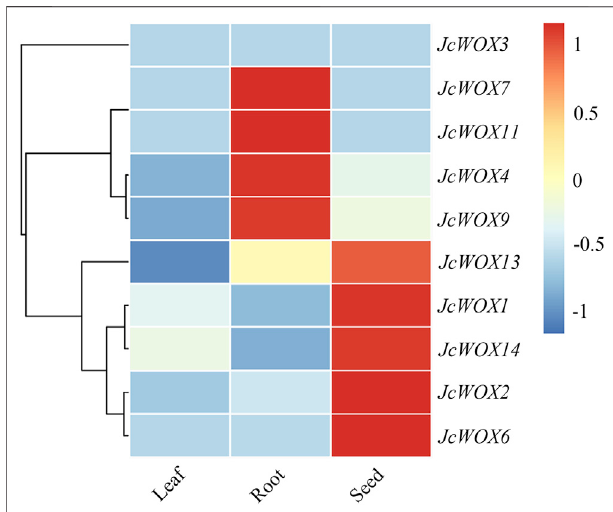
FIGURE 5 | Tissue-speci fi c expression patterns of 10 JcWOX genes. The role of JcWOX family members in the growth and development of roots and seeds may be more important than that of